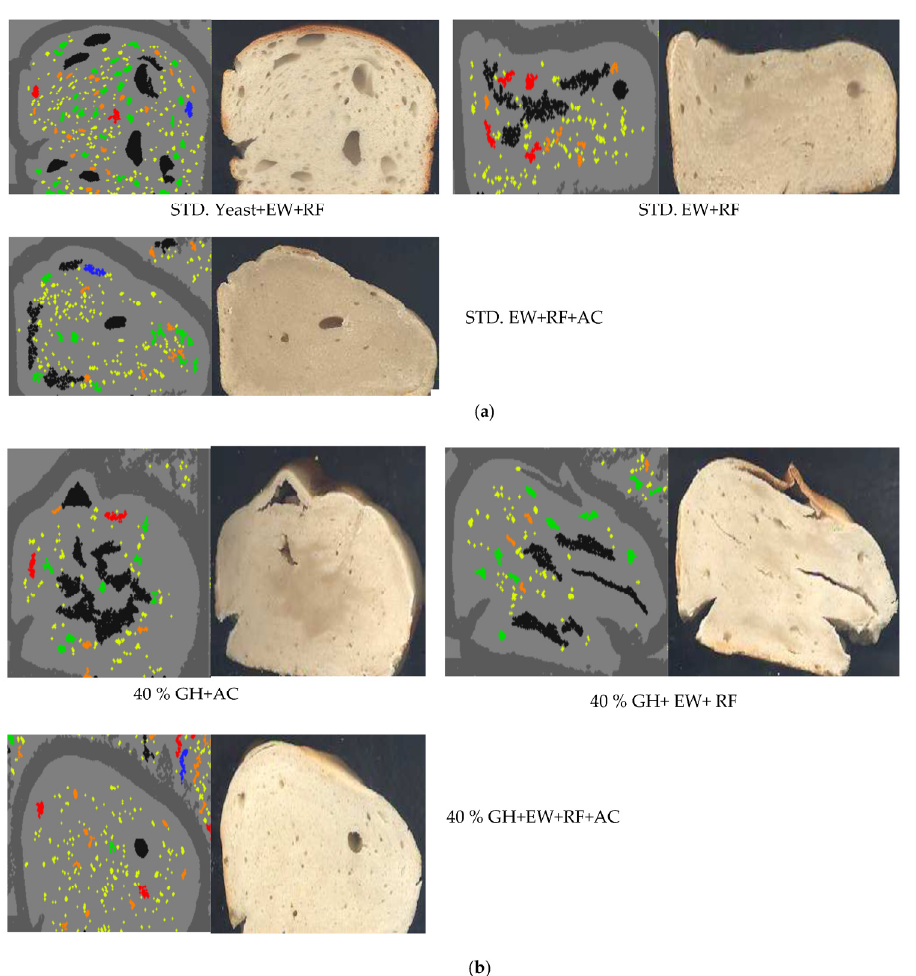
Figure 3. Cross sectional structures of GH bread with gelling agents in reference to gelling agents added to the standard breads. The addition of gelling agents along with GH improved pore distribution in the bread. The standards are shown in figure ( a ) with different combination of gelling agents with 40% GH in figure ( b ).